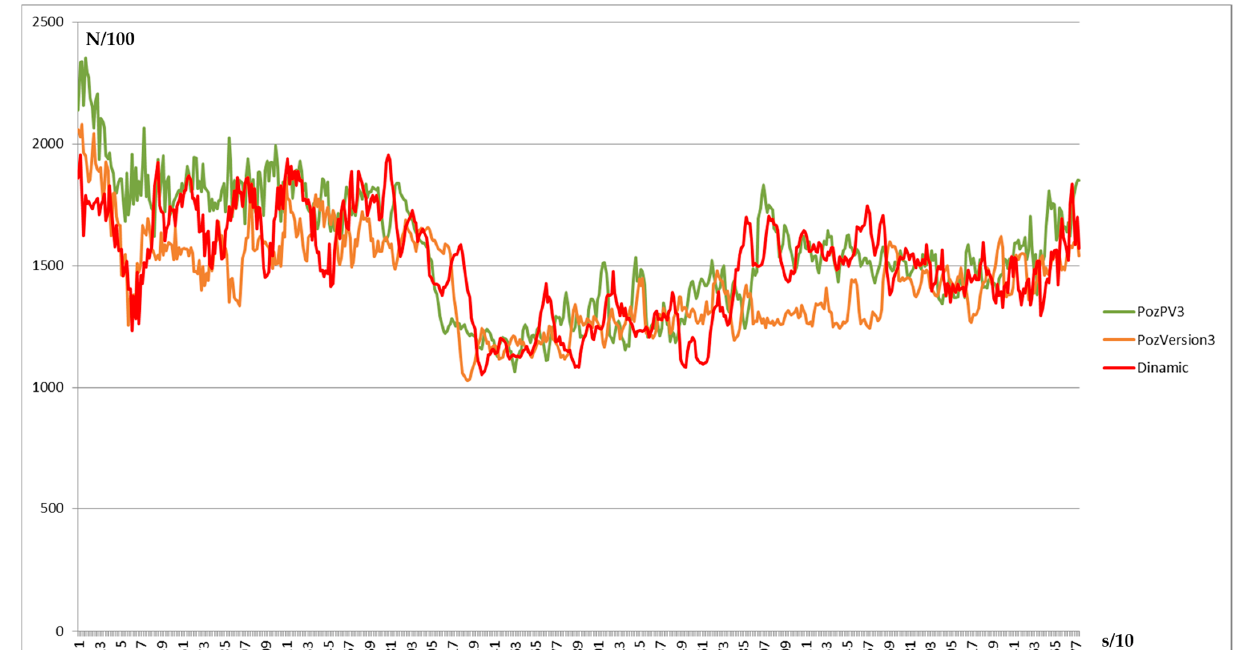
18 of 27 Figure 15. Proportional control system. A dynamical formula coming from a bipolar combined with the Proportional control method was also tested, like: